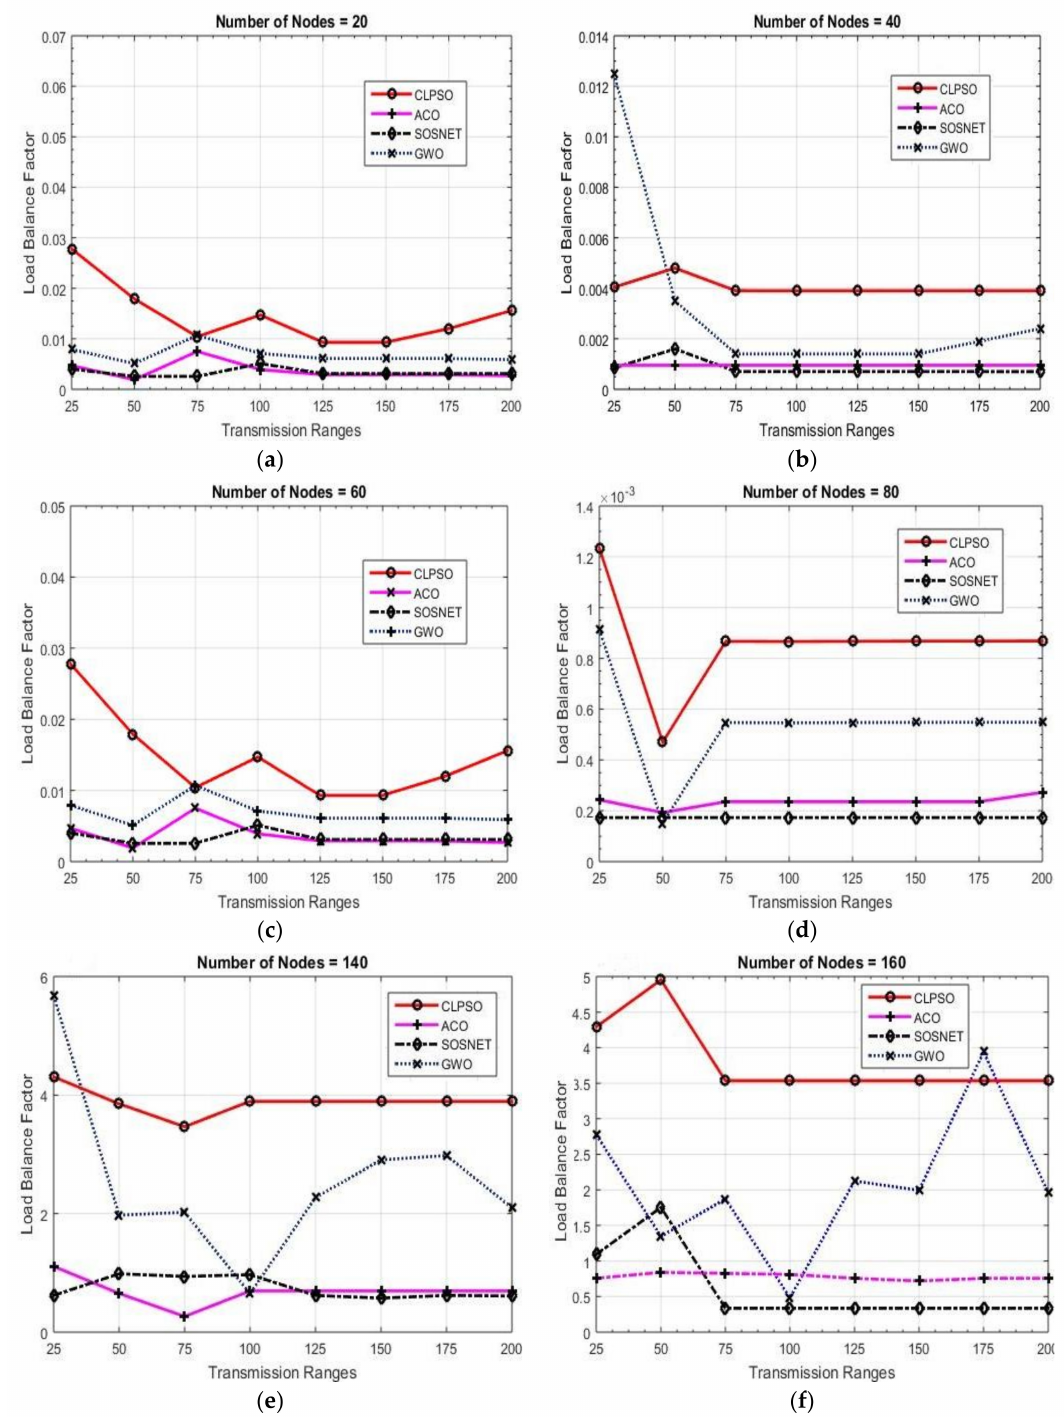
Figure 12. Load balancing factor for 1000 m × 1000 m grid and transmission ranges 25 m to 200